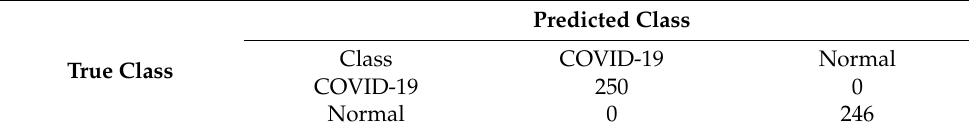
Table 7. Confusion matrix attained by ShuffleNet in binary classification scheme using CT